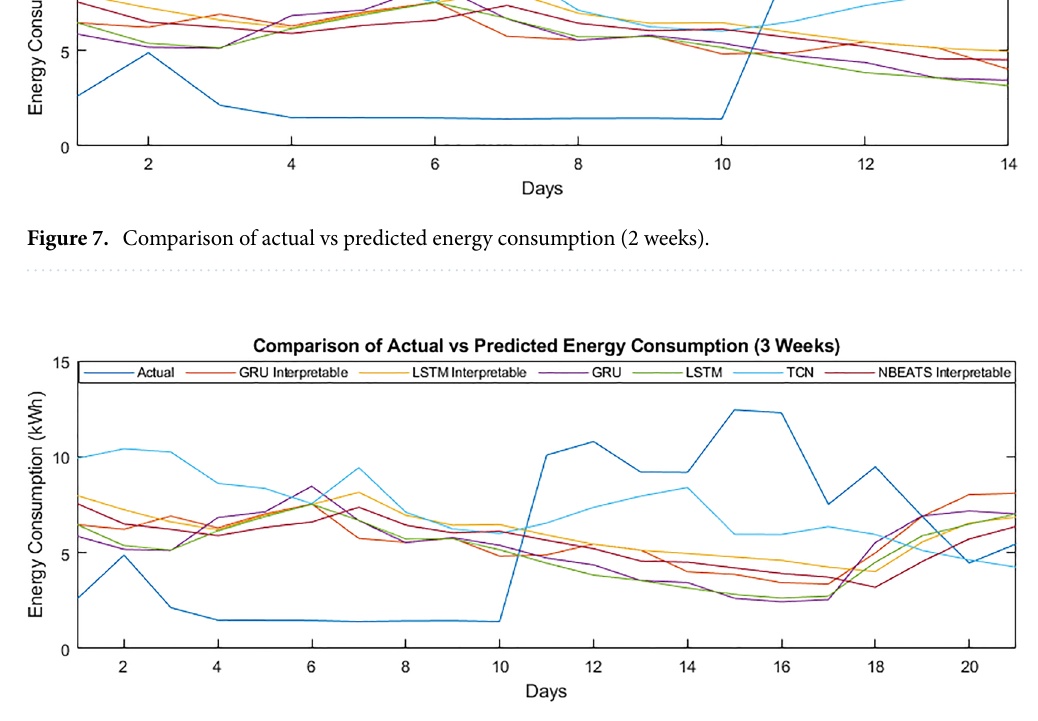
Figure 8. Comparison of actual vs predicted energy consumption (3